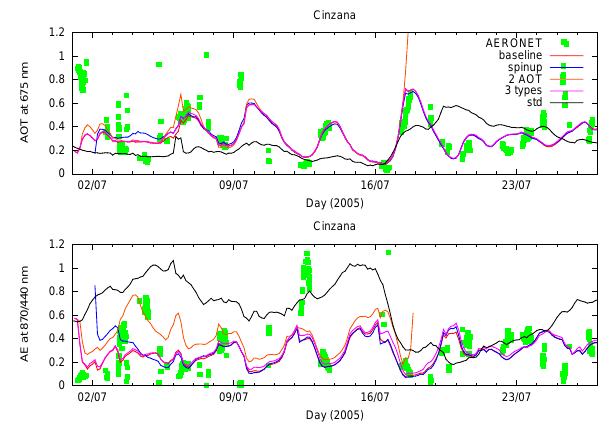
Fig. 17. AOT and AAE at Cinzana for various experiments. Also shown are actual observations (green squares).